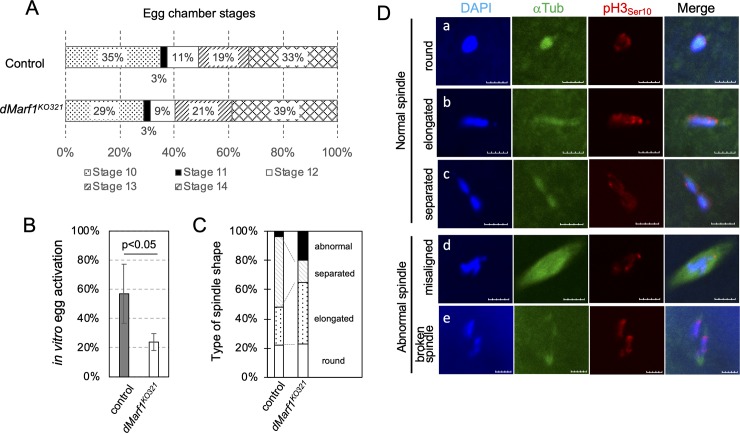
dMarf1 functions during the late stages of oogenesis.(A) The ratio of each stage is plotted for the egg chambers from heterozygous control ovaries (upper bar) and dMarf1KO321 ovaries (lower bar), respectively. Stages of egg chambers were assigned based on the standard King’s criteria [12]. (B) In vitro activation of stage 14 egg chambers. The average ratio ± standard deviation is shown for the control (n = 94) and dMarf1KO321(n = 158) ovaries (p < 0.05; Student’s t-test). (C-D) Meiotic spindles in stage 14 egg chambers. Most spindles in the control were round, long, or separated. By contrast, 20% of stage 14 egg chambers in the dMarf1KO321 ovaries contained abnormal (broken or mis-aligned) spindles. The ratio of each spindle shape type is plotted as a bar graph in (C) (n = 58 for control, and n = 91 for dMarf1KO321), and immunostaining of the corresponding spindle types are shown in (D). DAPI in blue, α-tubulin in green, phospho-histone H3 (an M-phase marker) in red. Scale bar, 5 μm.